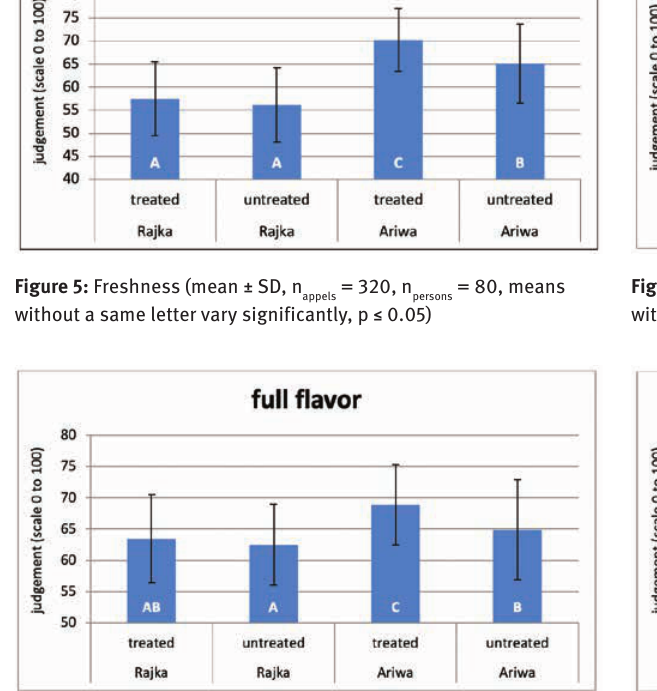
= 320, n = 80, means appels persons